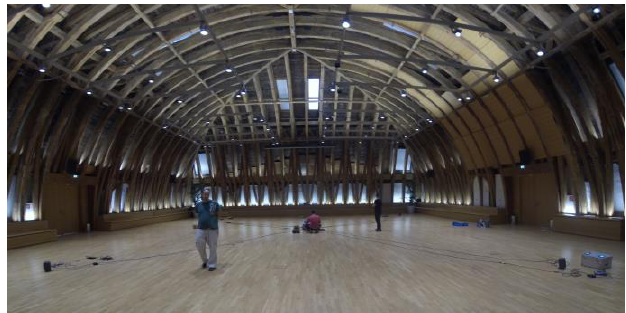
Figure 6. Center stage setting in the final location with four stations, one in each